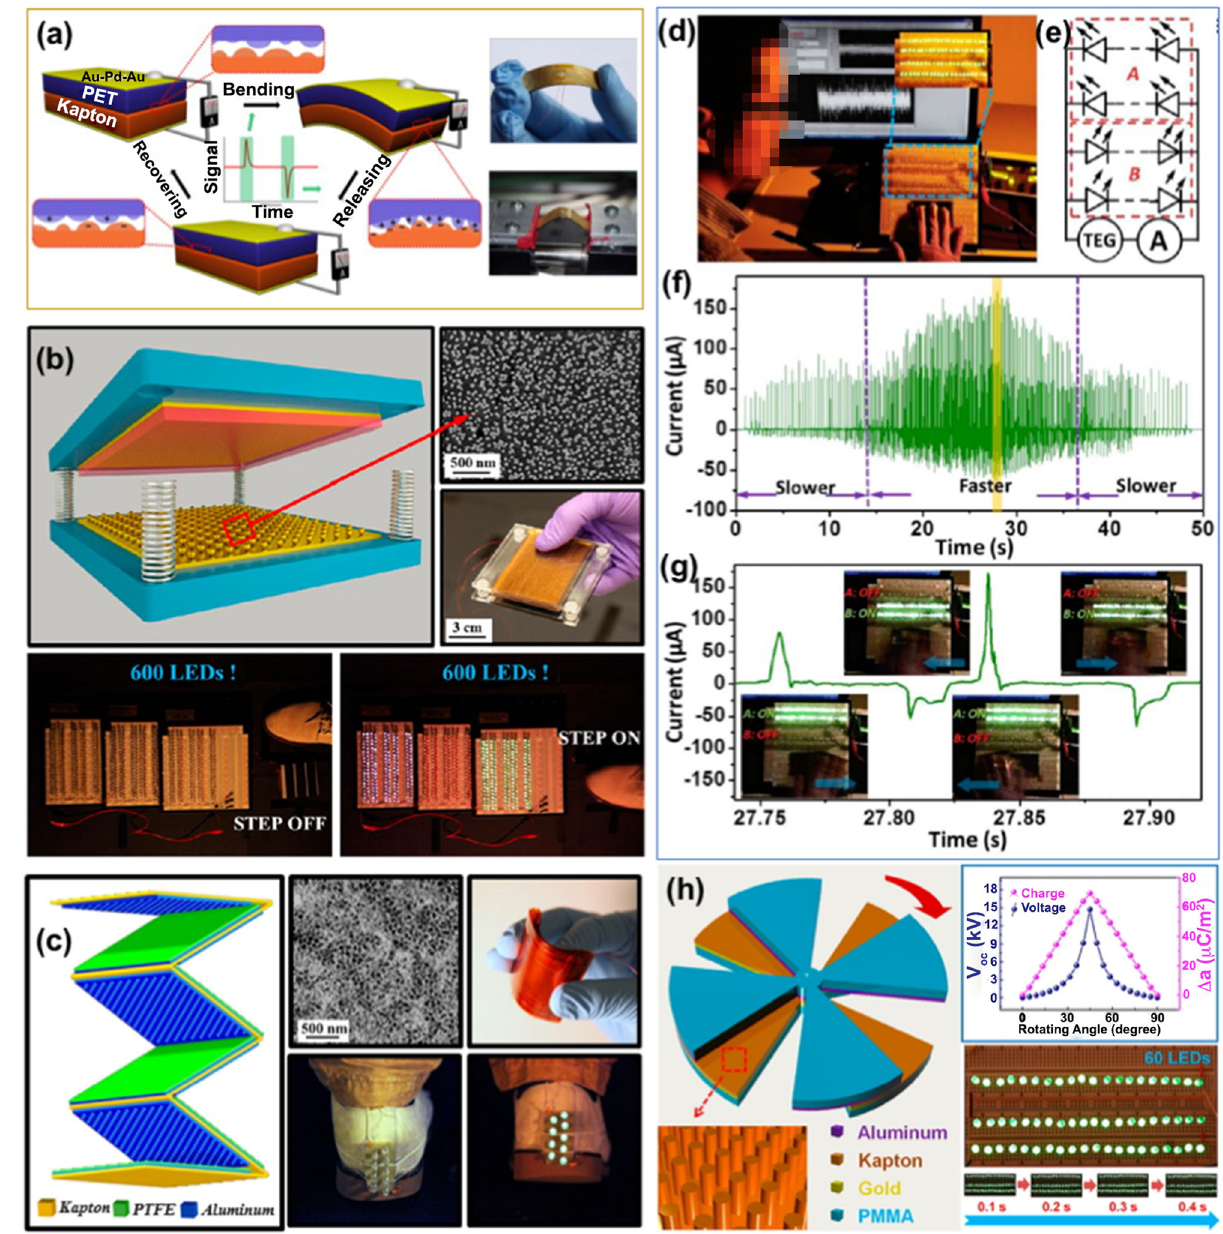
Fig. 4 Triboelectric energy generators. a 3D schema (left) and photograph (right) of fl exible TEG under bending conditions. Reprinted with permission from Fan et al. 37 Copyright © 2012 Elsevier Ltd. b 3D schema, SEM and photograph of TENG (top) and photograph of TENG powering 600 LEDs when footstep falls on the TENG (bottom). Reprinted with permission from Zhu et al. 122 Copyright © 2013, American Chemical Society. c 3D schema, SEM and photograph of fl exible multi-layered TENG, triggered by press from normal walking. Reprinted with permission from Bai et al. 44 Copyright © 2013, American Chemical Society. d Photograph of hundreds of LEDs lighted up by a TENG and e electric circuit. f Current generated by TENG from a human hand sweeping at different speeds. g Current peaks measured at each state of two groups of LEDs during hand sweeping; inset: photographs of the experiment. h 3D schema of disk TENG with segmental structure for harvesting rotational energy, electrical characteristics, and demonstration for powering up to 60 LEDs. Reprinted with permission